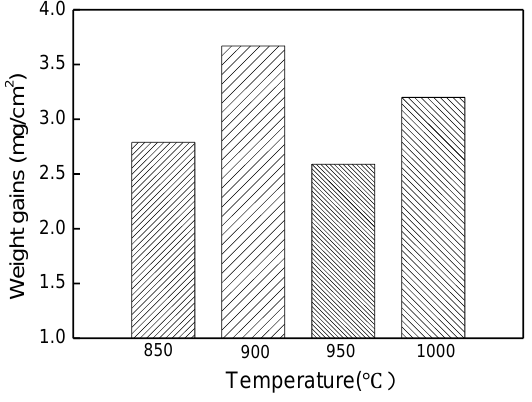
Figure 1. Weight gains of Ti heated up at 850–1000 °C in the aluminising pack for 0 h.